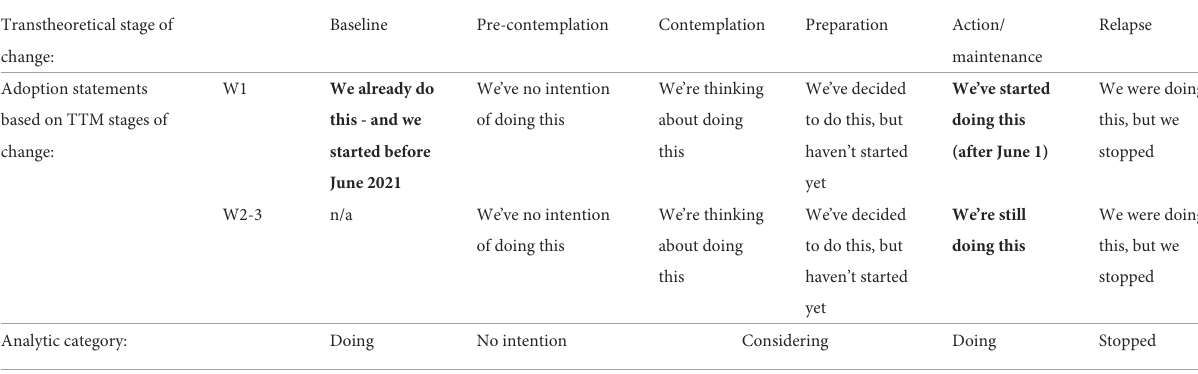
TABLE 3 The top three zoonoses about which participants thought they should be aware during routine equine reproduction